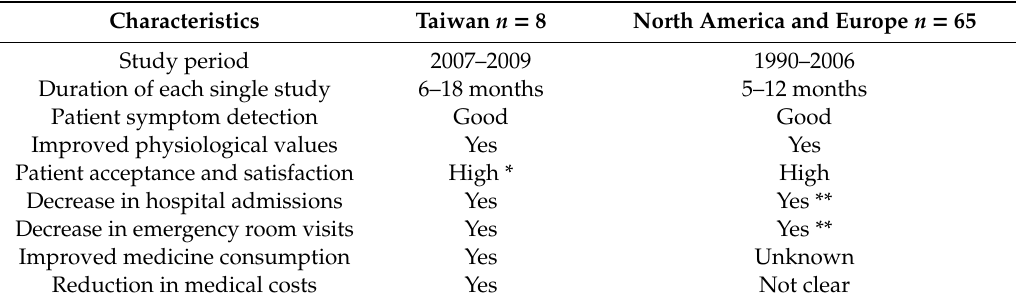
Table 2. Comparison of connected health (CH) in the US and EU. Table 1. Comparison of telecare results in Taiwan with the combined results of North America and